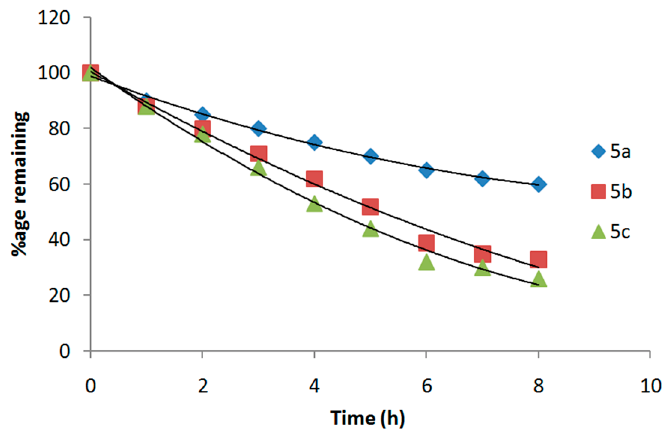
Figure 2. In vitro hydrolytic pattern of the ester prodrugs ( 5a – c ) in 80% human plasma (pH 7.4).